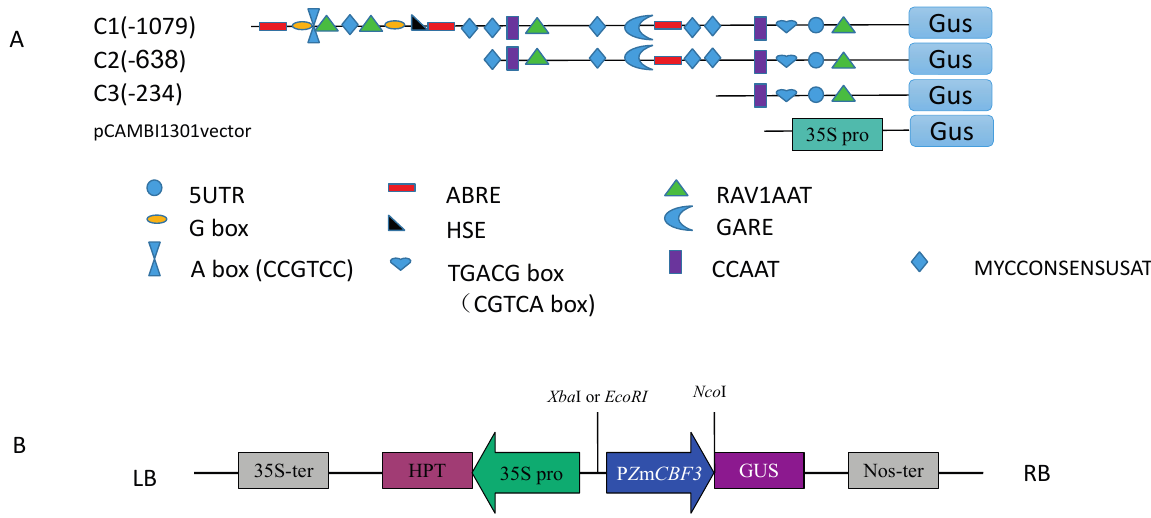
Figure 2. Transformation of Arabidopsis plants using P ZmCBF3:GUS constructs. ( A ) Schematic representation of the P ZmCBF3 promoter constructs used to analyze GUS expression in Arabidopsis leaves. The serial 5 ′ -deletion constructs of the P ZmCBF3 promoter were fused to the GUS reporter gene in the vector, pCAMBIA1301; ( B ) Schematic representation of the P ZmCBF3:GUS construct. The insertion position of the ZmCBF3 promoter in the vector is indicated with restriction enzyme sites ( Xba I or Eco RI and Nco I). LB, left border; RB, right border; 35S-ter, CAMV 35S terminator; 35S pro, CAMV 35S promoter; GUS, β -glucuronidase gene; HPTII, hygromycinphosphotransferase (II) coding region; NOST, nopaline synthase terminator; P ZmCBF3 , ZmCBF3 promoter.